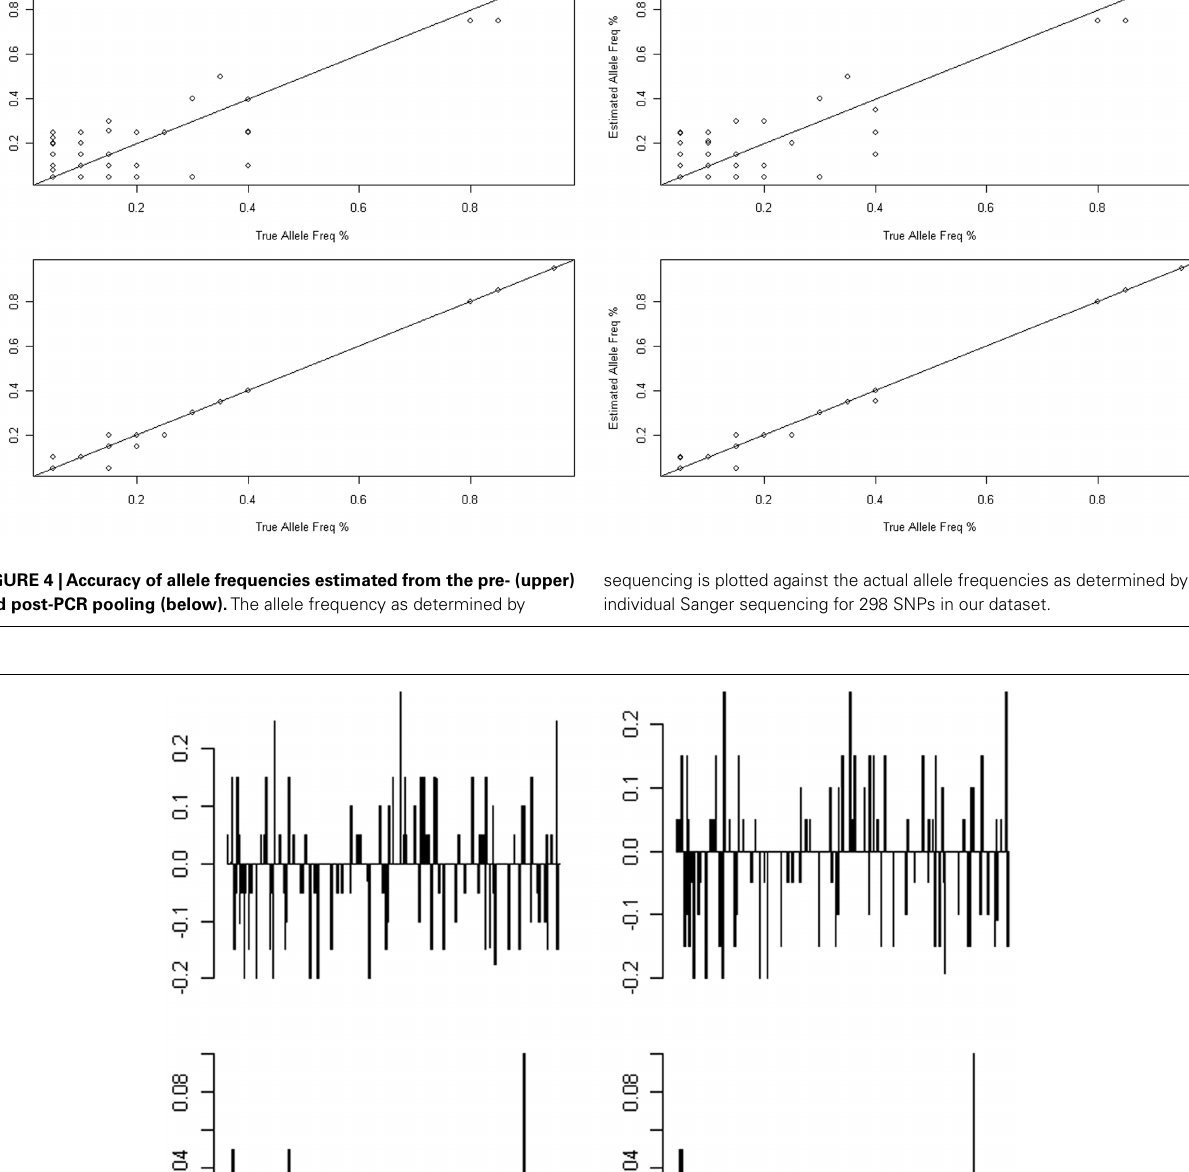
for 298 SNPs in the sample. The two pre-PCR pools are shown in the upper row and the two post-PCR pools are shown in the lower row in each